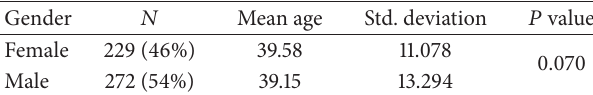
Table 4: Total patients in study (age and gender).